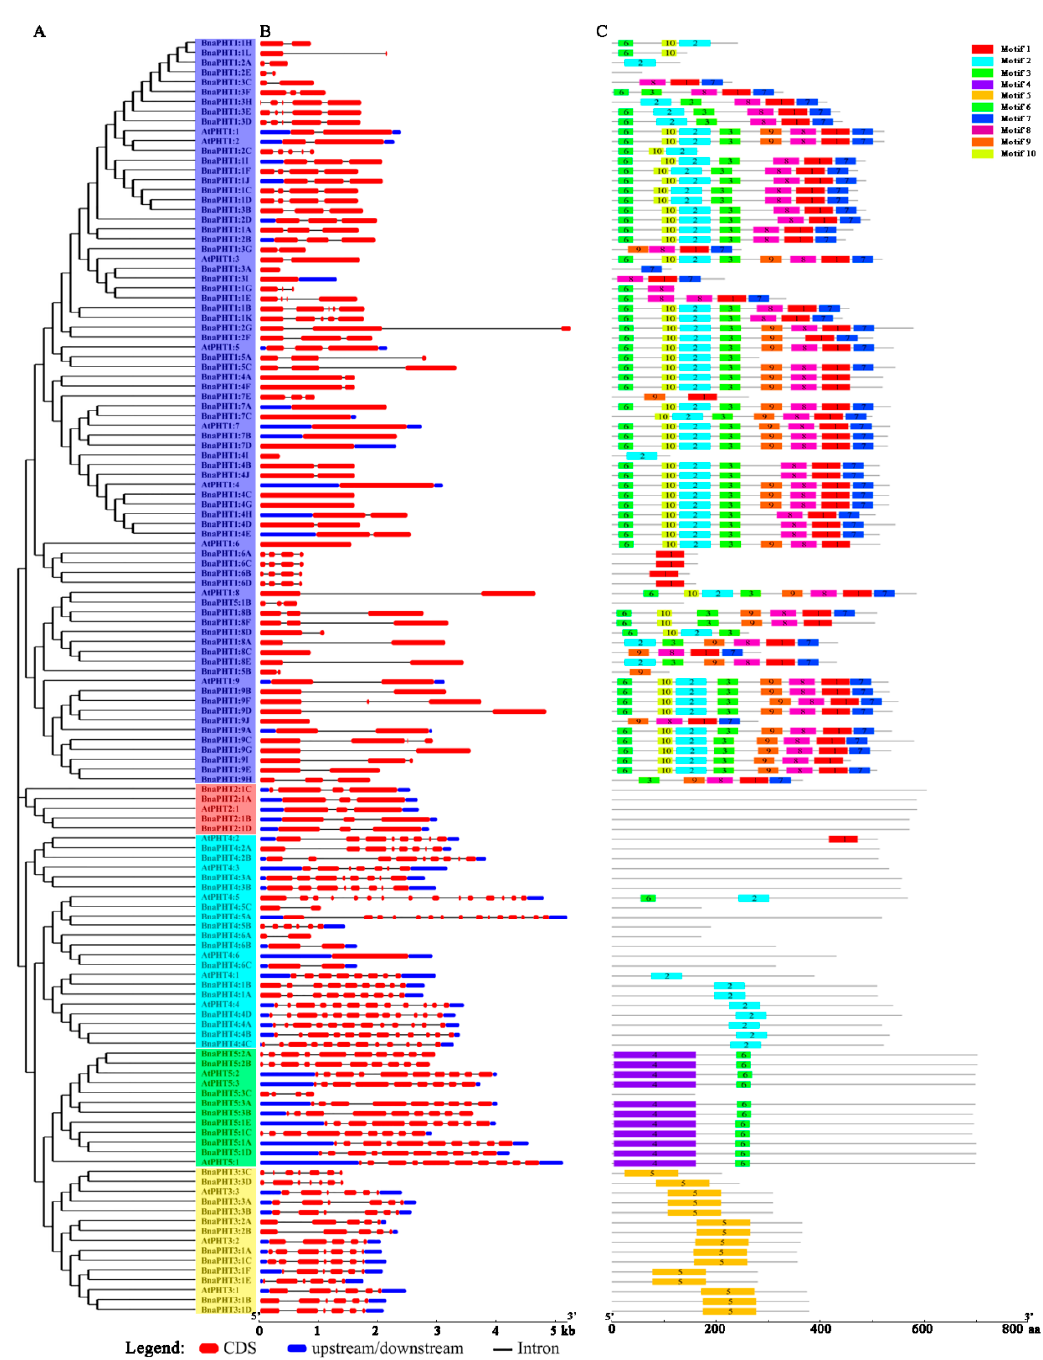
Figure 4. Analysis, gene structures, and protein motifs of PHT genes between A. thaliana and B. napus . ( A ) Phylogenetic tree. Full-length coding sequence (CDS) were aligned with Clustal X 2.0, and the phylogenetic tree was constructed using the neighbor-joining method. ( B ) Gene structures. Red boxes represent exons and gray lines represent introns. The untranslated regions (UTRs) are indicated by blue boxes. The sizes of the exons and introns can be estimated using the scale at the bottom. ( C ) Protein motifs. Conserved motifs (1–10) are represented by different colored boxes, whereas nonconserved sequences are indicated by gray lines.